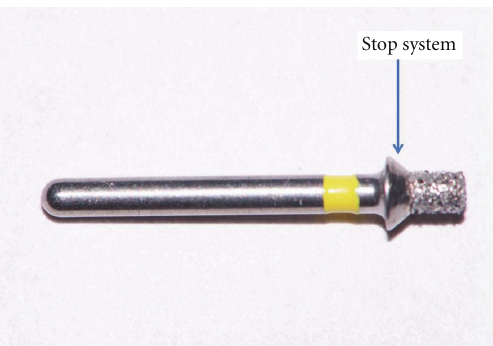
Figure 1: View of the diamond bur used for cavity preparations. Arrow shows the stop